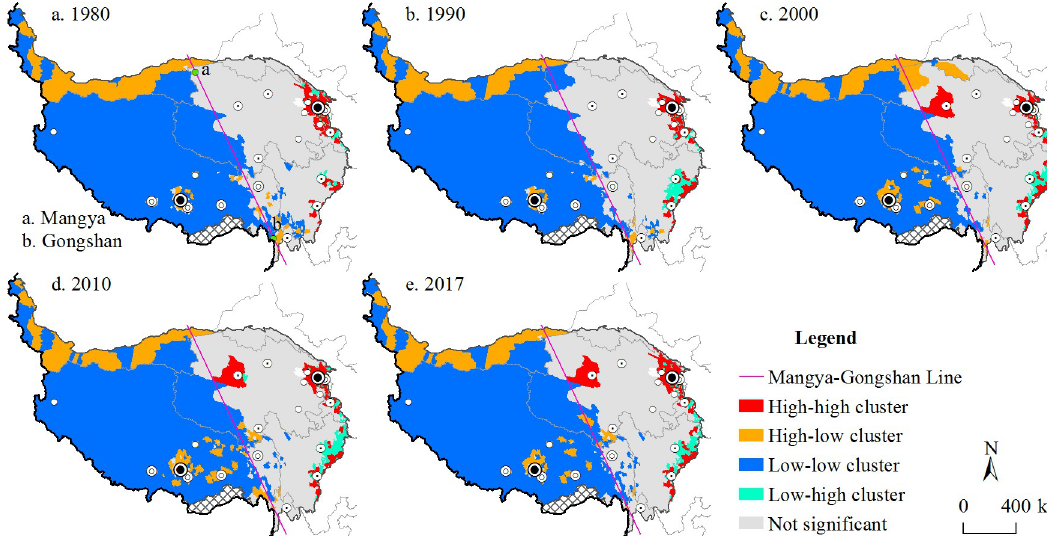
Fig 7. Bivariate local spatial autocorrelation clustering of township social demand and potential accessibility.